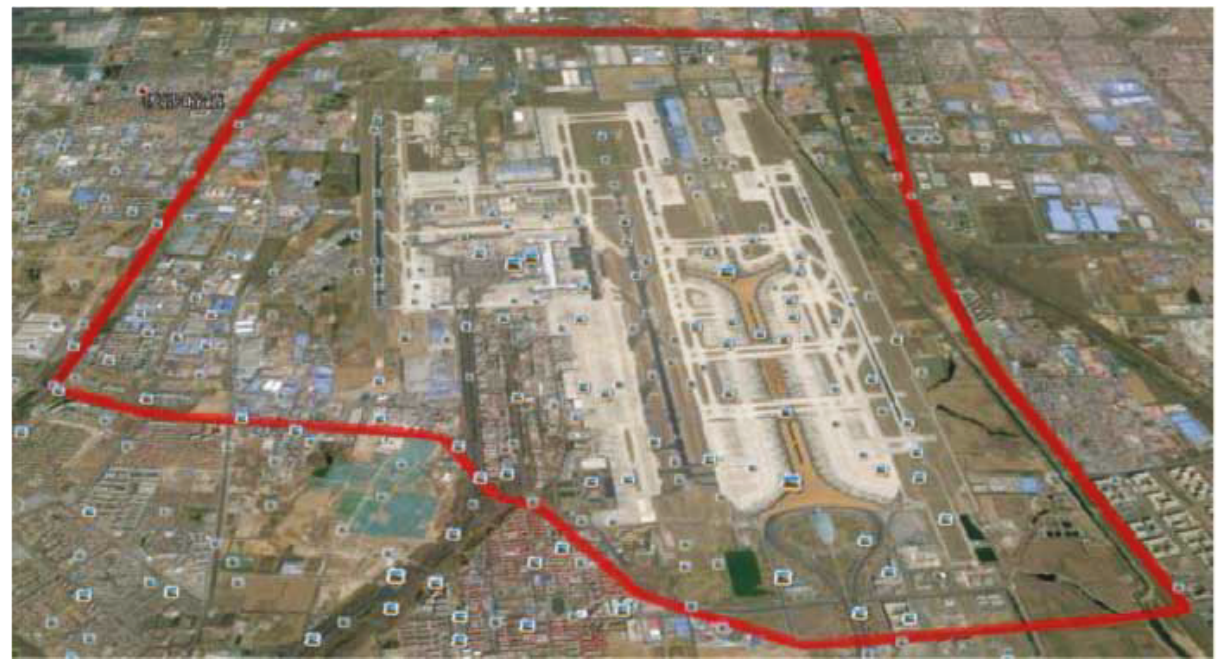
Figure 6: Monitoring path.